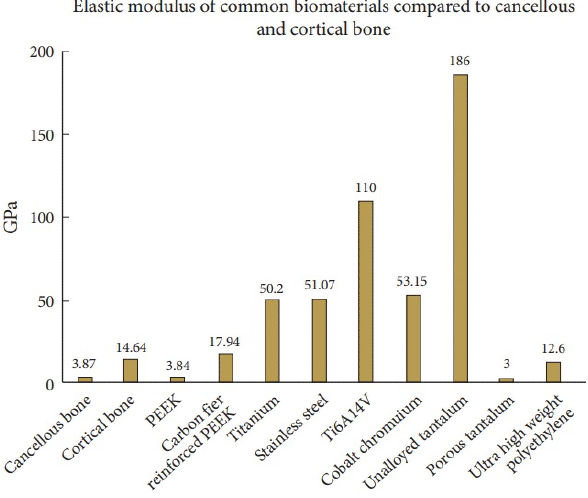
Figure 1: Young’s modulus of common